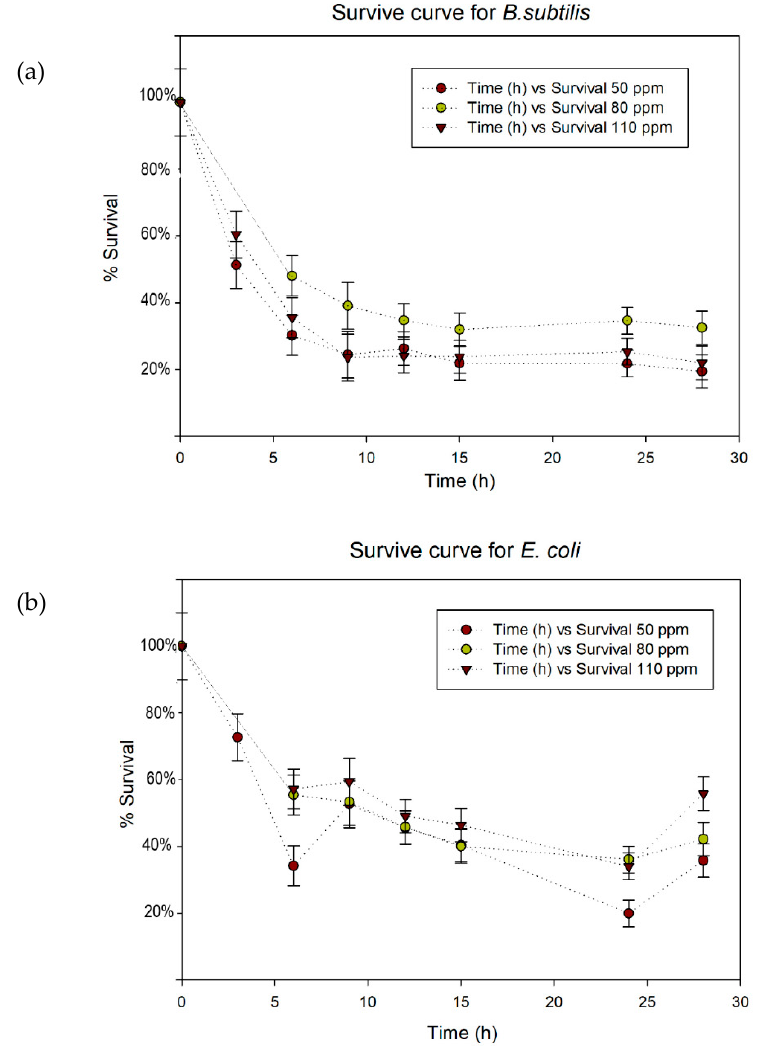
Figure 5. Survival curves for B. subtilis ( a ) and E. coli ( b